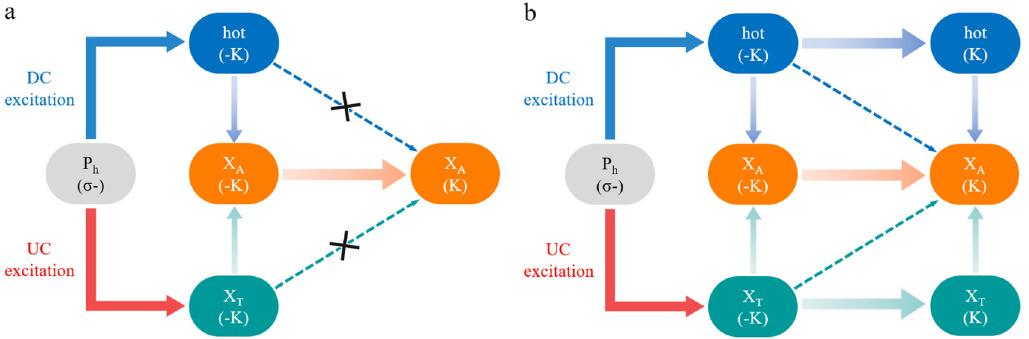
Figure 5: The depolarization model in downconversion (DC) and upconversion (UC) scenarios. (a) Direct conversion channels from trions and hot carriers in − K valley into the A-excitons in K valley are forbidden. (b) With intermediate depolarization of trions and hot carriers, possible conversion occurs from trions and hot carriers in − K valley into the A-excitons in K